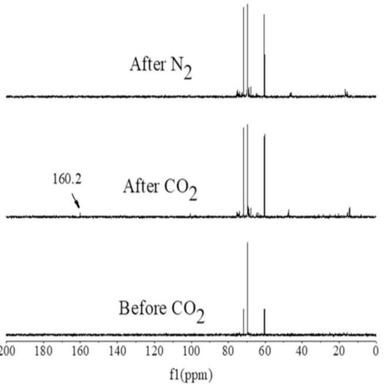
13C NMR spectrum of CO2-responsive phase transfer materials (PEG-200) before bubbling of CO2, after bubbling of CO2, and after the removal of CO2 by bubbling N2.